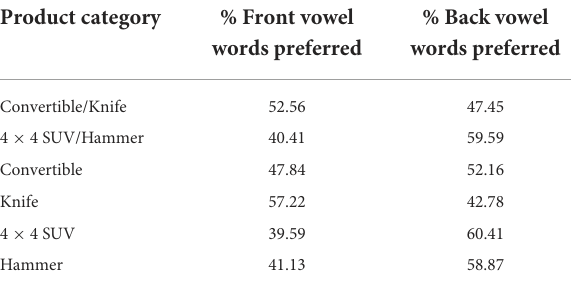
TABLE 3 Summary of findings that the current research replicated Shrum et al. (2012). Product